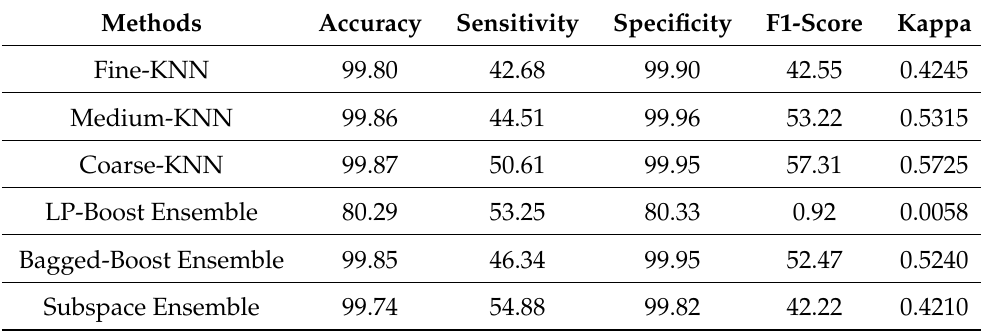
Table 5. Results of 5-fold predictions using deep features.